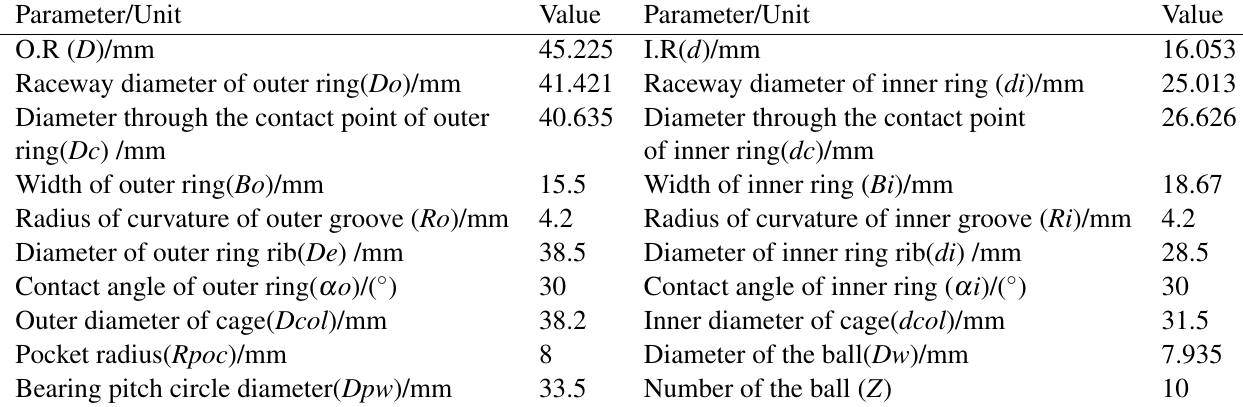
Table 1 Structural parameters of the